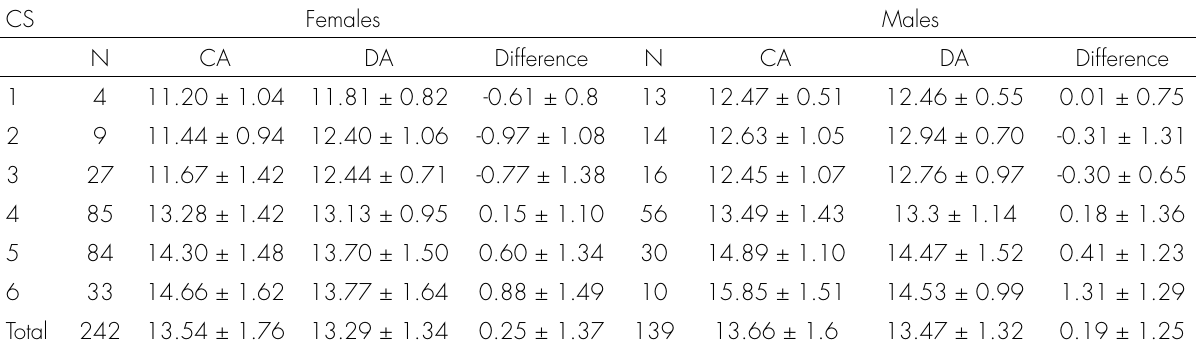
Table I. Chronological age (CA) and dental age (DA) corresponding to all CVM stages (CS = Cervical Maturational